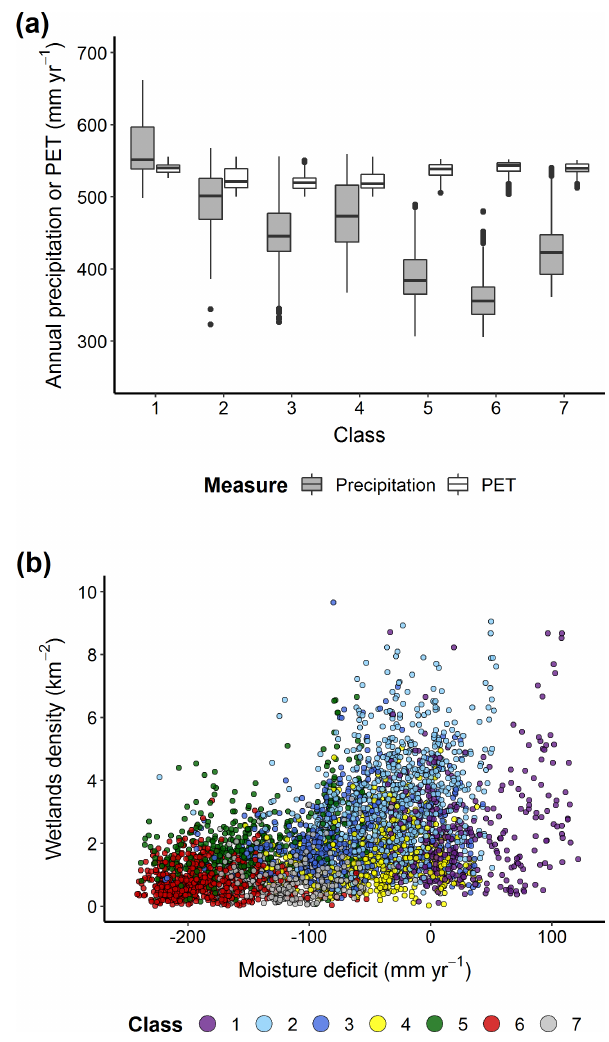
Figure 6. Climatic variation among watershed classes. (a) Box- plots of total annual precipitation (grey) and potential evapo- transpiration (PET) (white) for each watershed cluster. Lower, middle, and upper limits of boxes show the 25th, 50th, and 75th quantiles, respectively. (b) Wetland density to moisture deficit (precipitation − PET). Classes: Southern Manitoba (1), Pothole Till (2), Pothole Glaciolacustrine (3), Major River Valleys (4), In- terior Grasslands (5), High Elevation Grasslands (6), Sloped In- cised